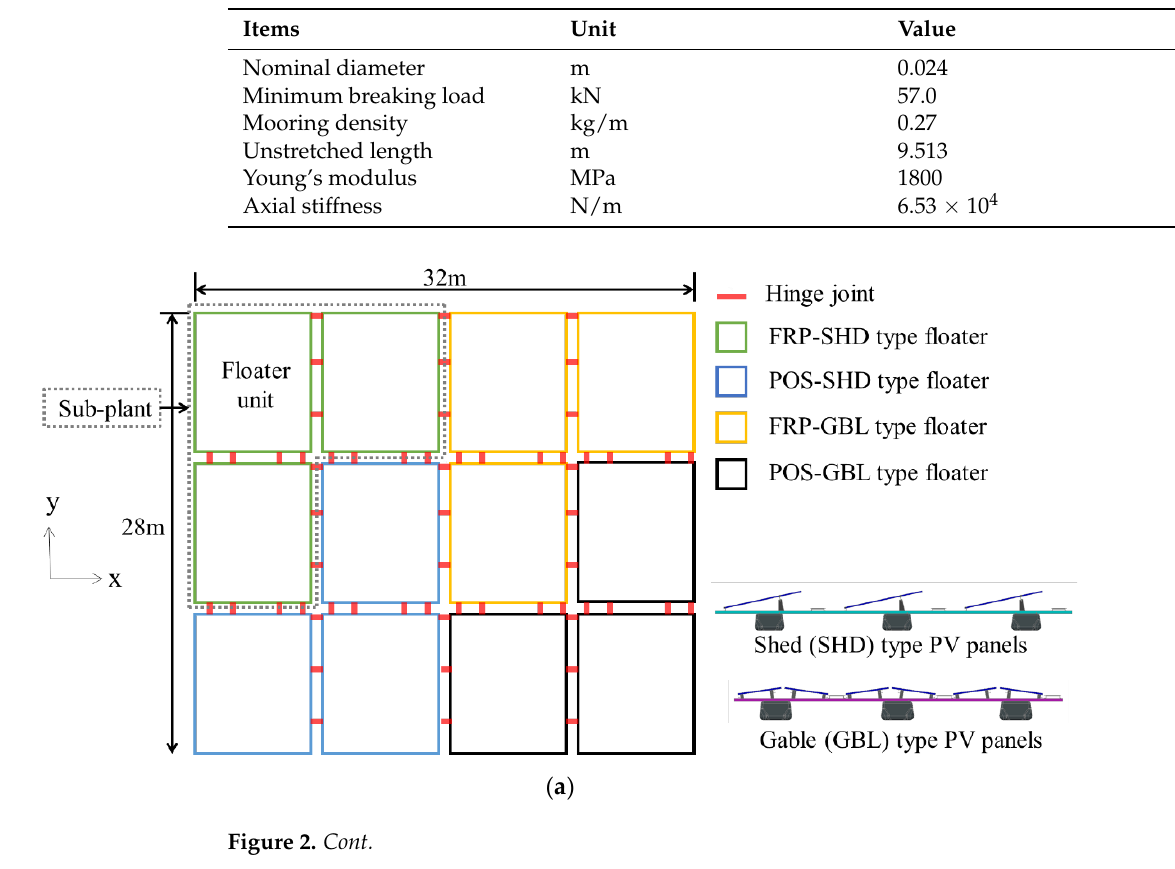
Table 1. Properties of mooring systems.